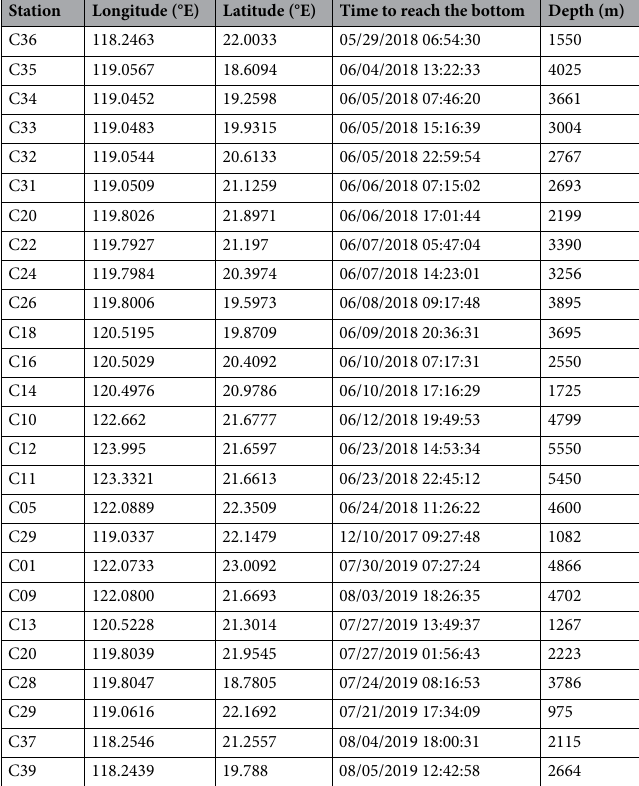
Table 1. VMP-X stations and deployed